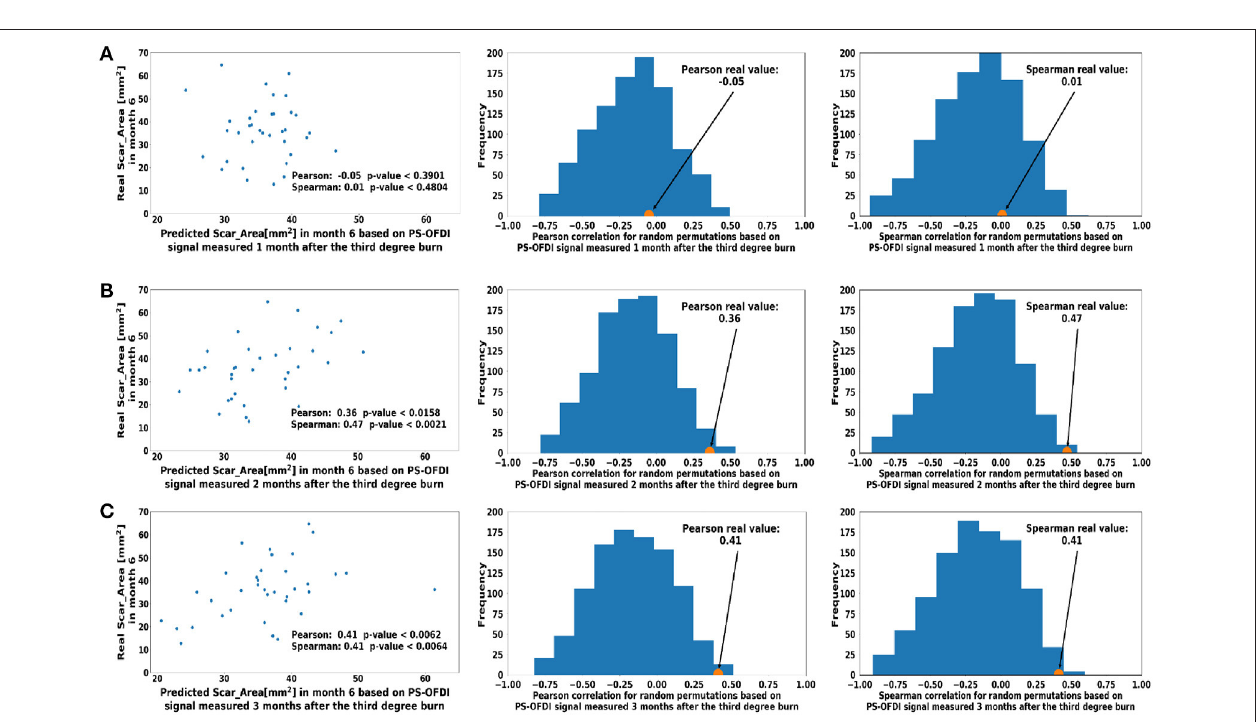
FIGURE 3 | Predicted scar area at month 6 based on measurements taken at a single time point (A) . Month 1 (B) . Month 2 (C) . Month 3 after third-degree burn injury. The control histograms of the correlation coefficients corresponding to randomly shuffled measurements appear on the right-hand side of each panel.